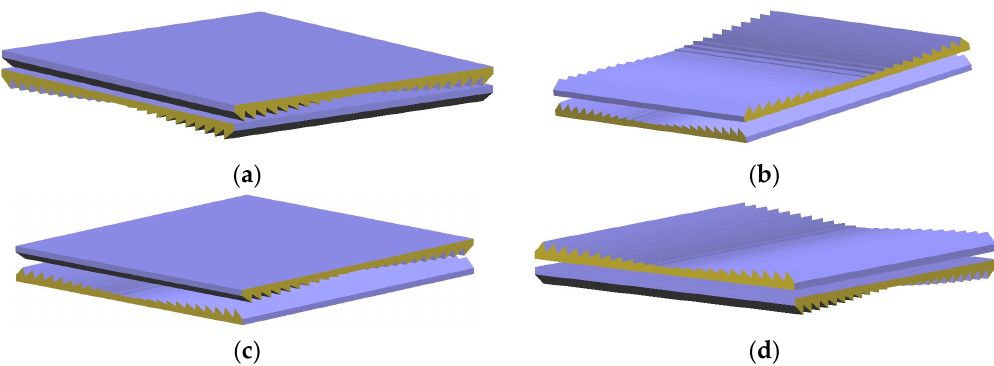
Figure 13. Four structures of the POE using a combination of two individual Fresnel lenses that are constructed from ( a ) two lower groove surfaces, ( b ) two upper groove surfaces, ( c ) one lower groove surface above one upper groove surface, and ( d ) one upper groove surface above one lower groove surface.